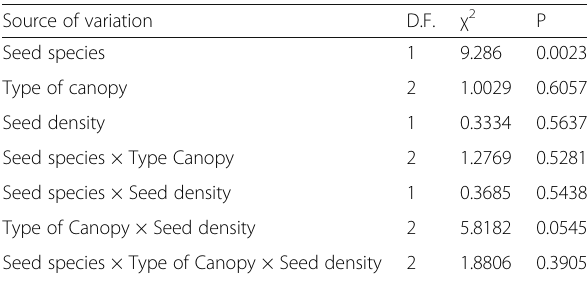
Table 2 Degrees of freedom (D. F.), χ 2 and P -value of the generalized linear mixed-effects model analysis testing the effects of seed species ( Ipomoea murucoides , I. pauciflora ), Type of canopy ( I. murucoides , I. pauciflora , control area) and seed proportion of I . murucoides : I . pauciflora (8:0, 6:2, 4:4, 2:6 and